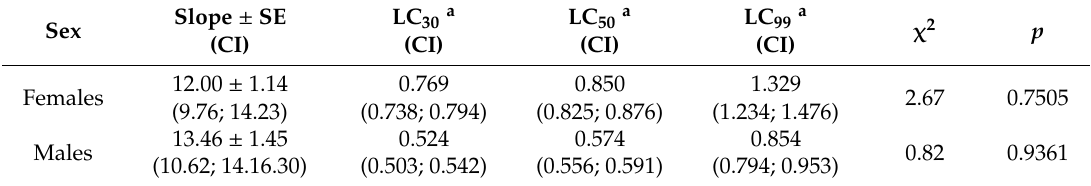
Table 1. Residual contact toxicity of thyme oil against Acanthoscelides obtectus females and males. Slope ± SE Sex Females